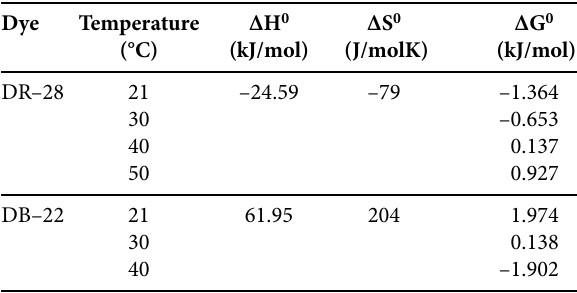
Table 2. Thermodynamic parameters for the adsorptions of DR-28 and DB-22 onto